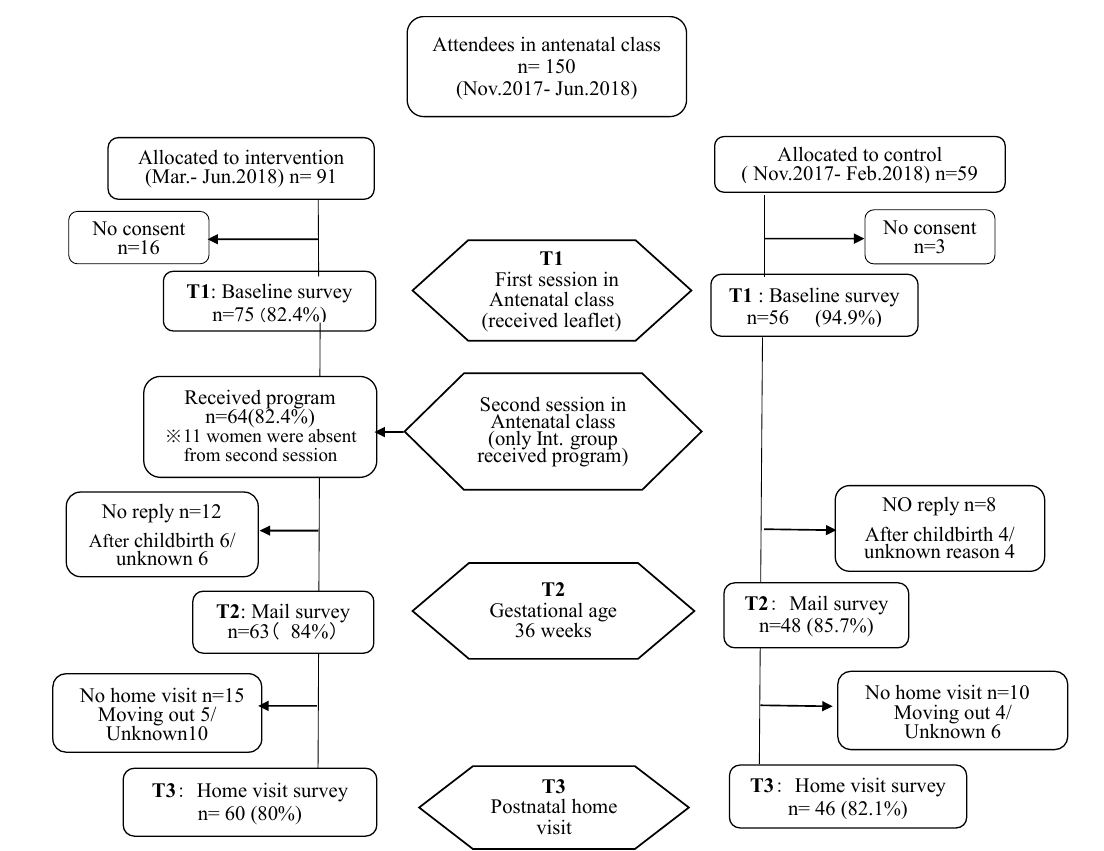
Figure 1. Flowchart of participant registration and progress. Table 3. Baseline characteristics of study participants ( n =